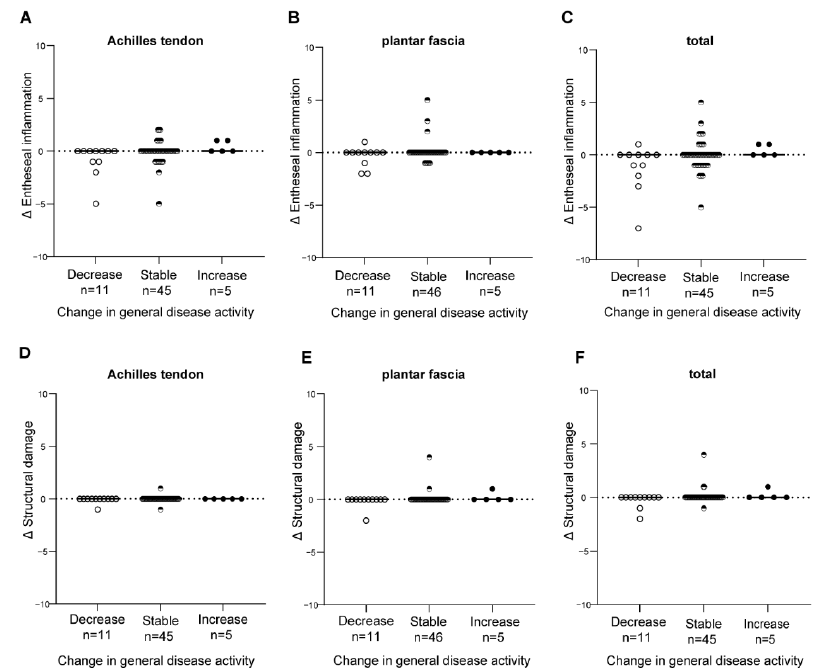
( B ) T2 SPAIR weighted image showing no hypersignal at the retrocalcaneal bursa. Figure Legend: SPAIR = Spectral Selection Attenuated Inversion Recovery. J. Pers. Med. 2022 , 12 , 1765 SPAIR = Spectral Selection Attenuated Inversion Recovery.